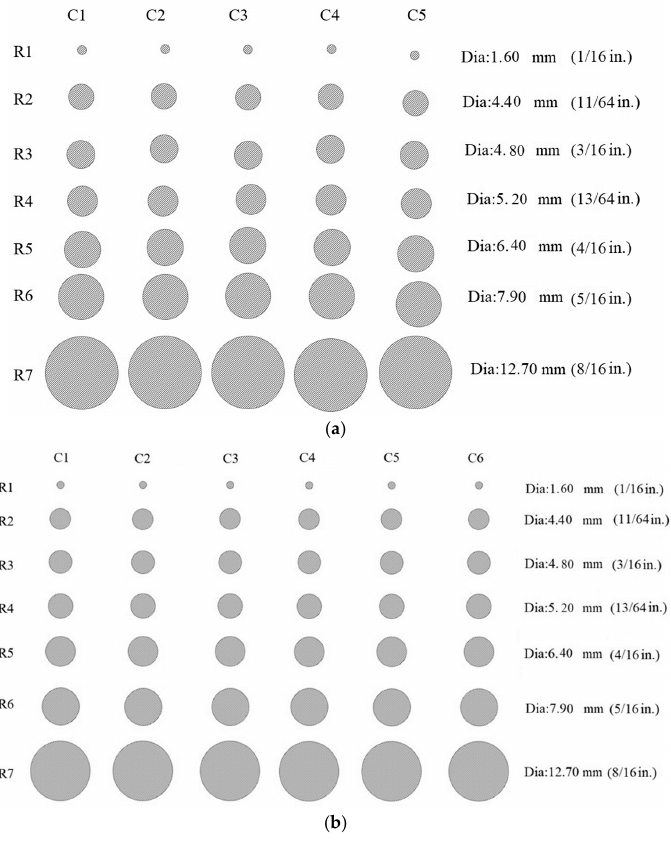
Figure 2. Configuration of the defects created inside the tank wall: ( a ) defects on the internal east side of the tank; ( b ) defects on the internal west side of the tank.